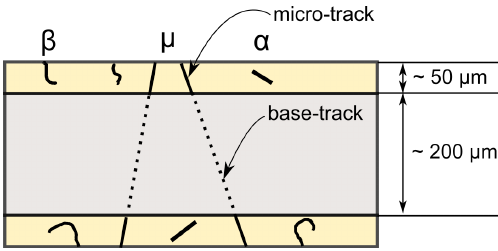
Figure 4. Schematic view of emulsion film. Definition of micro-track and base-track.